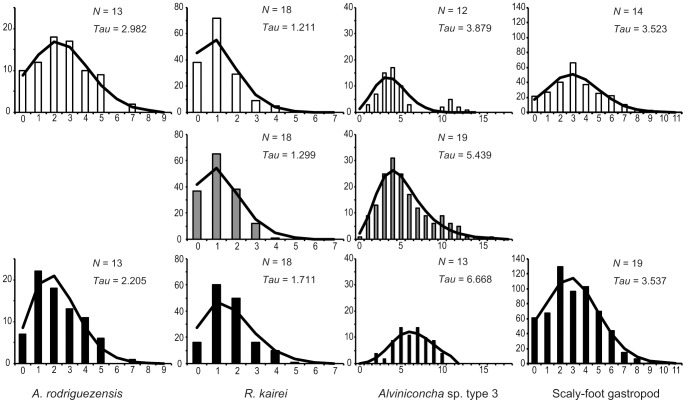
Mismatch distribution of the four representative species in the CIR.A, A. rodriguezensis; B, R. kairei; C, Alviniconcha sp. type 3; and D, scaly-foot gastropod. Black, population in the Kairei field; gray, population in the Edmond site; and white, population in the Solitaire field.